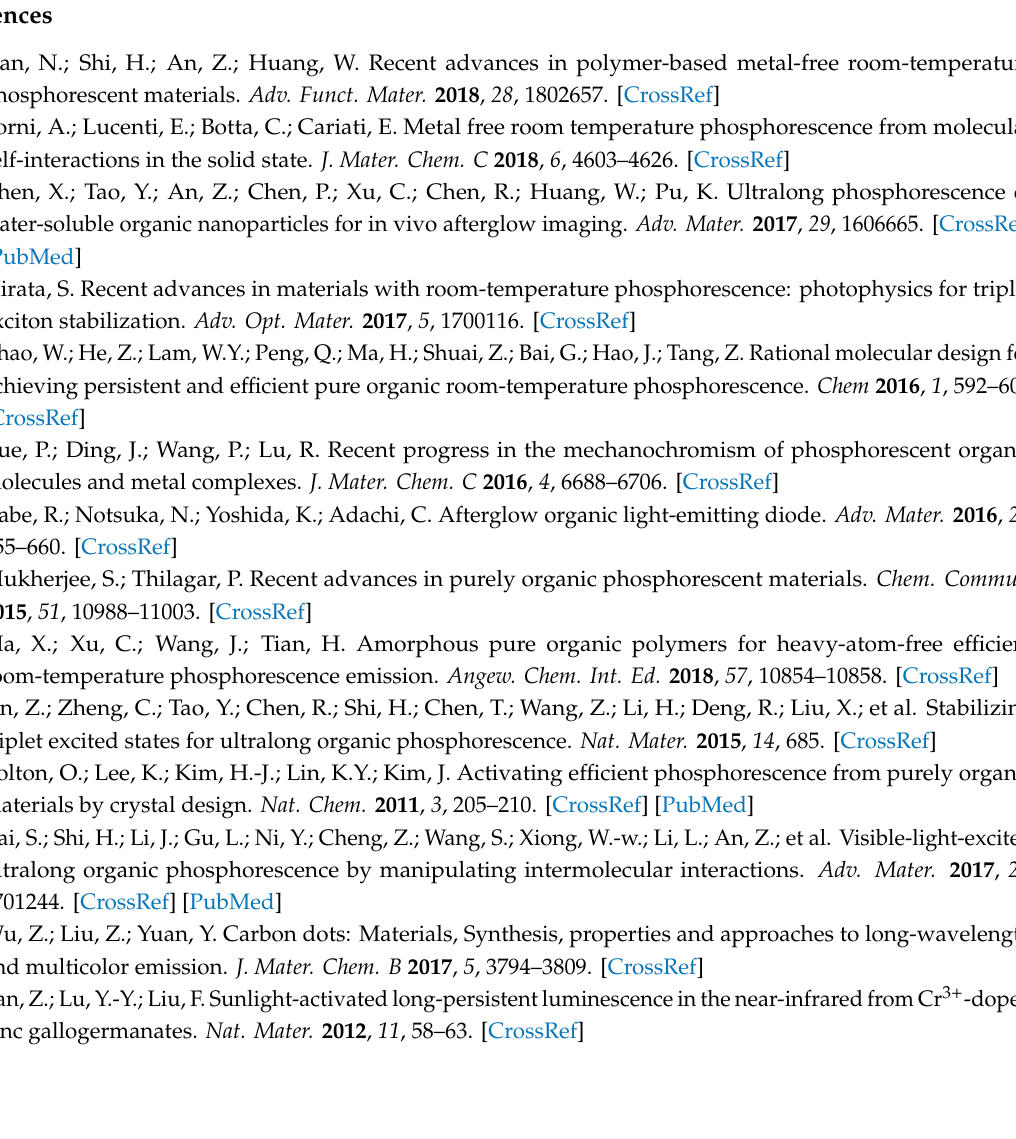
of AA-CDs-2 water dispersion. Figure S9: Phosphorescence emission spectra at di ff erent excitation wavelengths and excitation spectrum of the L-aspartic acid (a) and AA-CDs-2 (b) powders at ambient conditions. Figure S10: Photographs of the AA-CDs-2 powder at ambient conditions under day light, and visible (Vis.) light LED ( λ em = 420 nm) on and just being switched o ff , respectively. Table S1: QYs of AA-CDs and AA-CDs-2 aqueous dispersion. Table S2: Fitted parameters of the FL decay curves of the AA-CDs powder and water dispersion. Table S3: Fitted parameters of the phosphorescence decay curves of the L-aspartic acid, AA-CDs and AA-CDs-2 powder. Table S4: Relative contents of C, N and O elements of the AA-CDs and AA-CDs-2on the basis of the XPS data. Table S5: Relative contents of di ff erent functional groups in the AA-CDs and